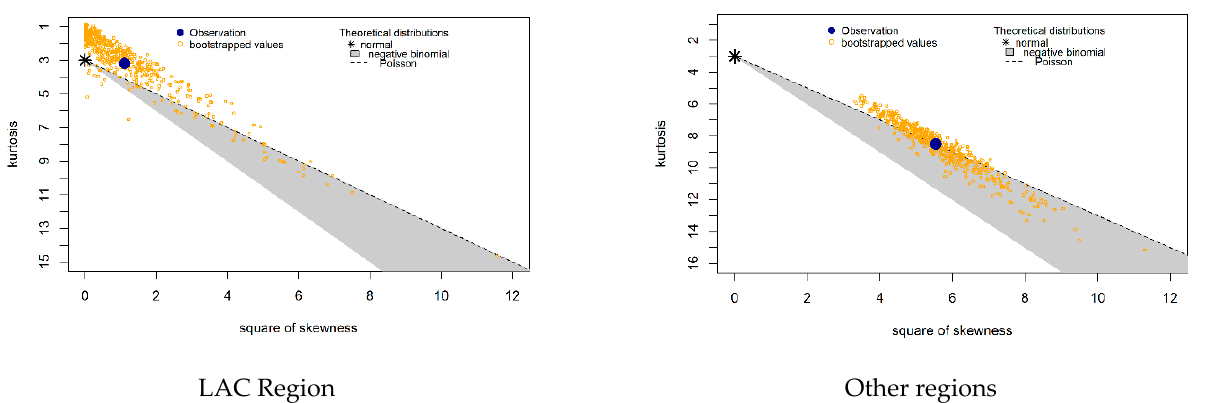
Figure 10. Cullen and Frey graph of total citations in the last 3 years for LAC journals and other regions.